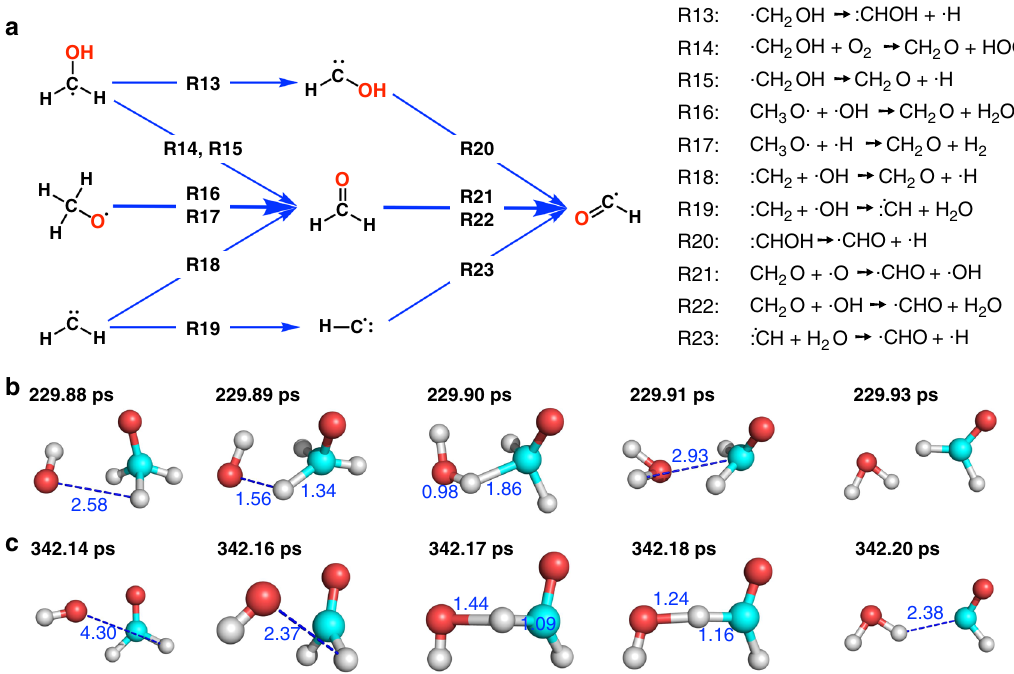
Fig. 3 Production of formaldehyde and formyl radicals. a The main reaction pathways for the formation of formaldehyde and formyl radicals. b The real- time trajectory of the reaction CH 3 O· + ·OH → CH 2 O + H 2 O. Atoms in cyan, red and gray colors are carbon, oxygen and hydrogen, respectively. c The real- time trajectory of the reaction CH 2 O· + ·OH → ·CHO + H 2 O. De fi nition of colored atoms is the same as in ( b